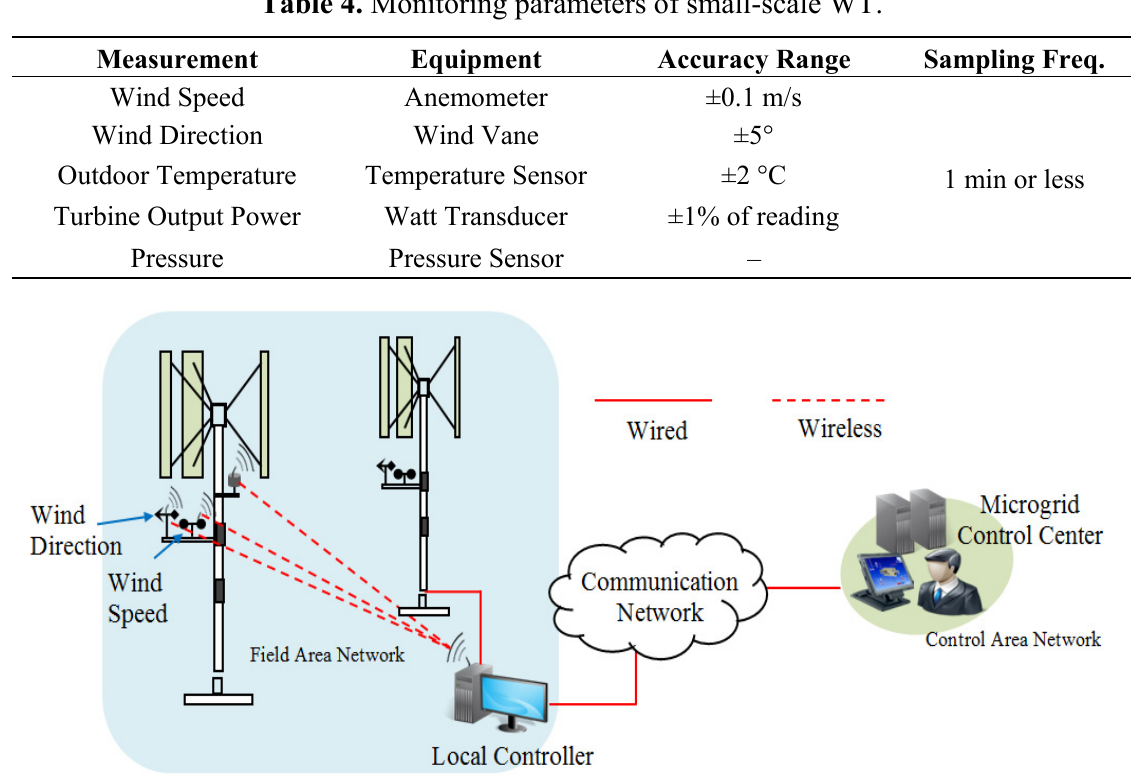
Figure 5. Communication network for a small-scale